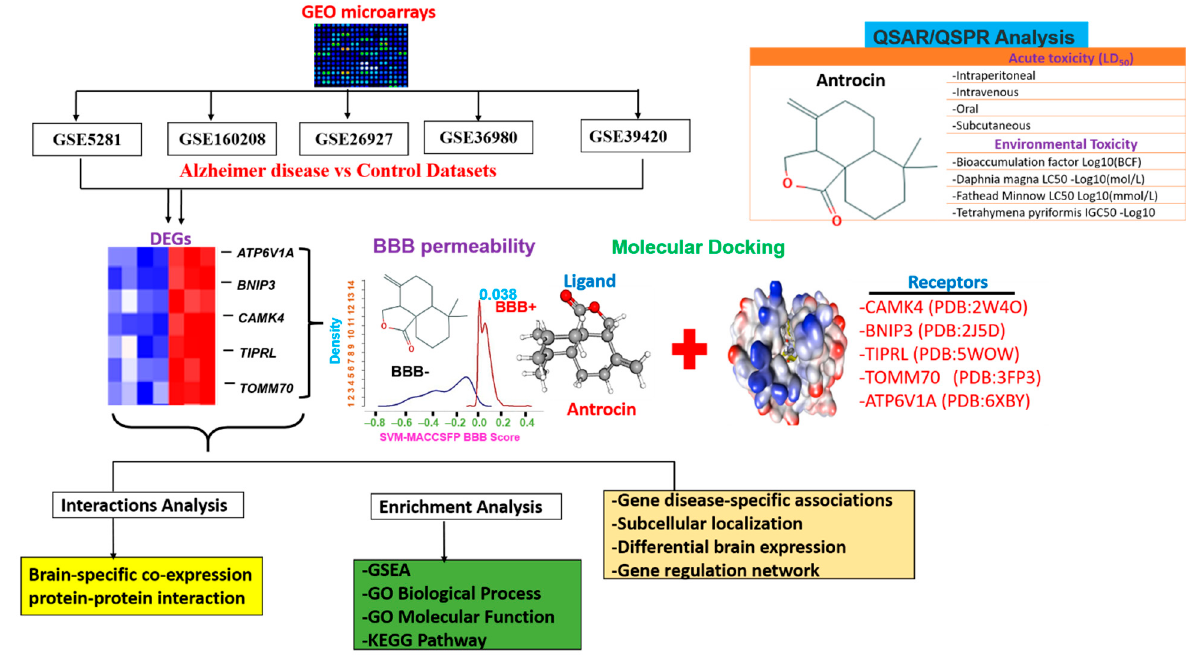
Figure 1. The flow chart of the study design for in silico identification of potential targets for Alzheimer’s disease and antrocin as a therapeutic candidate.